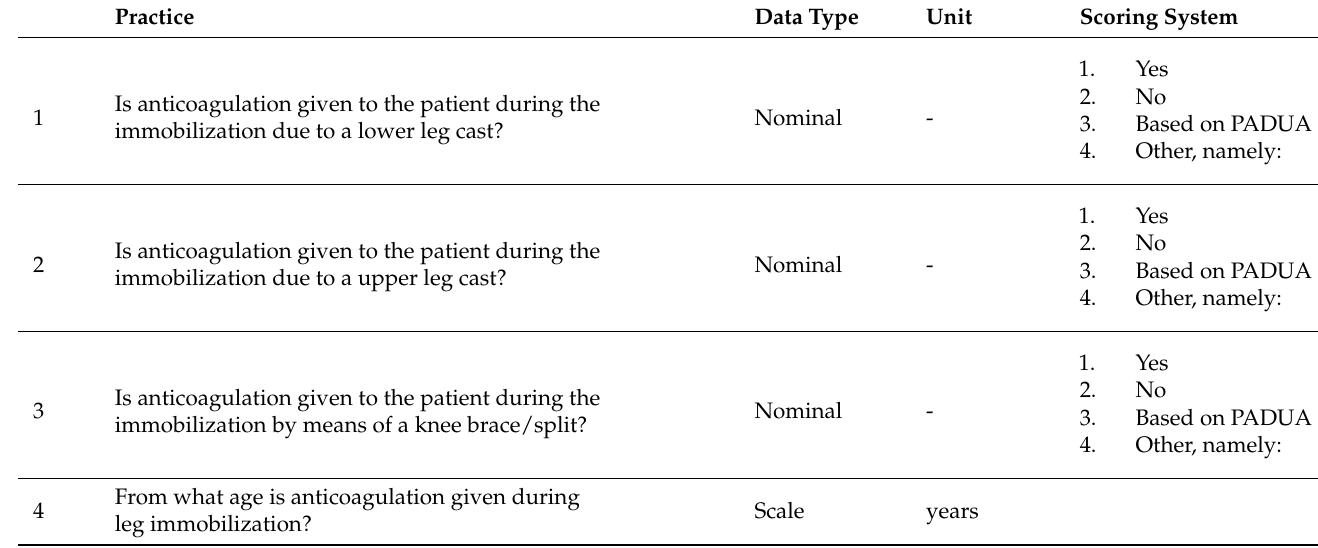
Table A1. Content questionnaire practice